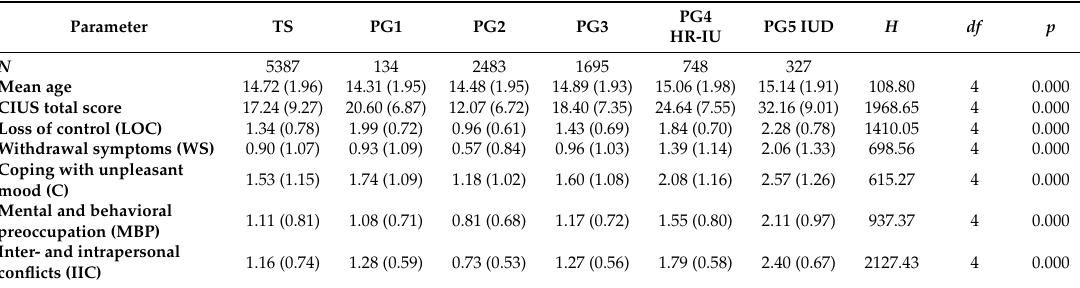
Table 3. Symptom severity across profile groups: mean CIUS symptom scales and total